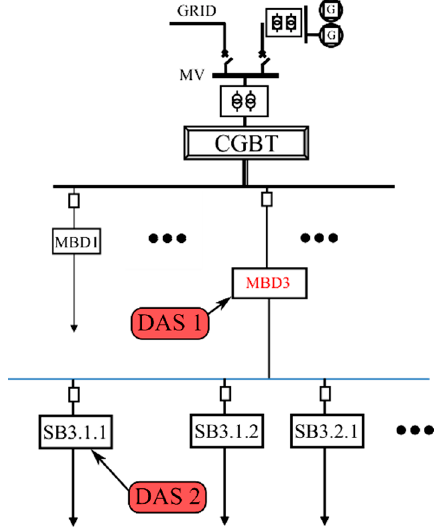
Figure 5. Data acquisition system (DAS) locations at the hospital. Energies 2017 , 10 , 64